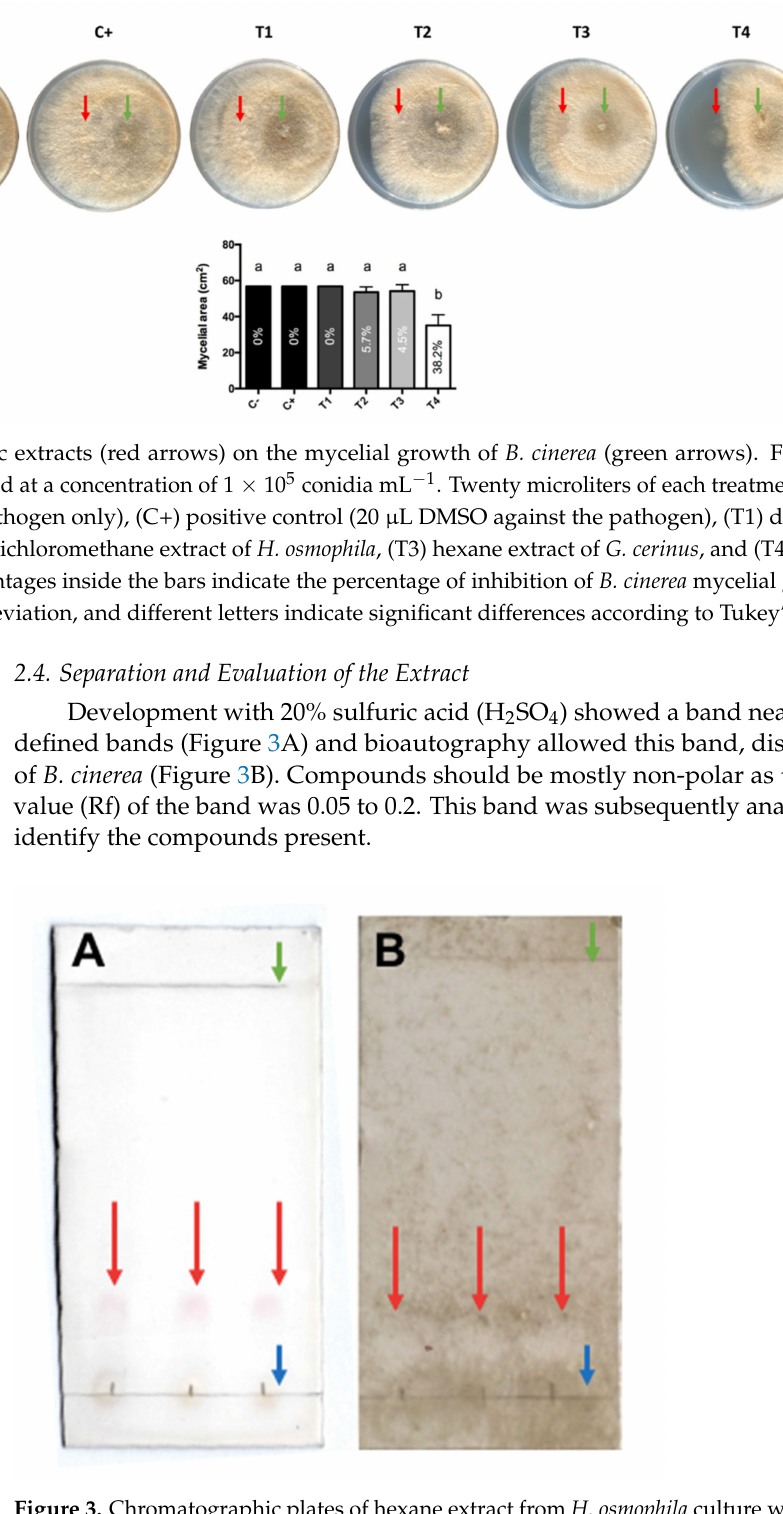
Figure 3. Chromatographic plates of hexane extract from H. osmophila culture with mobile phase Hex: EtOAc (6: 1). The chromatographic plates show three lanes as replicates. ( A ) TLC plate developed with 20% H 2 SO 4 where red arrows indicate revealed compounds; and ( B ) Results for the direct bioautography assay where red arrows indicate growth inhibition of B. cinerea at Rf = 0.05 to 0.2. Green arrows indicate the solvent front and blue arrows indicate the starting